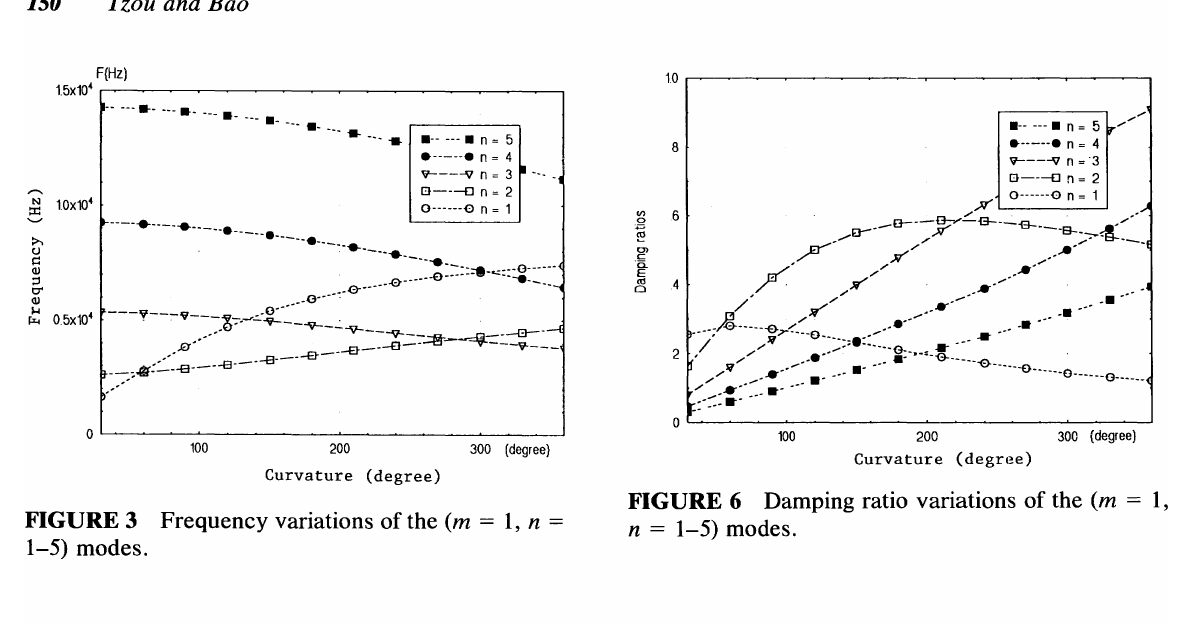
FIGURE 3 Frequency variations of the (m 1-5) modes.